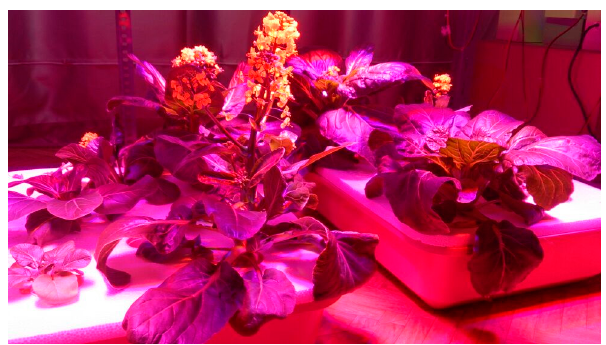
Figure 11. High variable intensity at 300 µmol m − 1 s − 1 after 30 days of sowing.